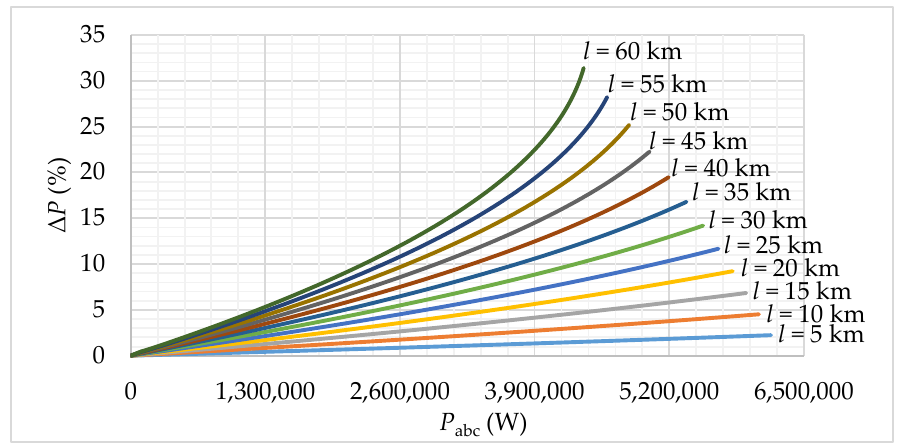
Figure 4. The dependence of increasing APLs from three-phase active power consumption for ACSR 95/15 without consideration of voltage dip.